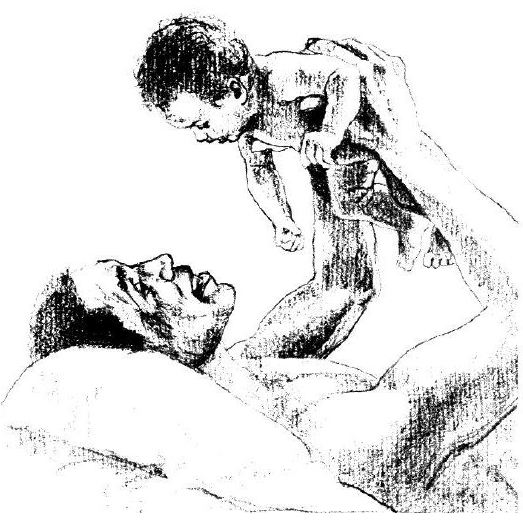
Figure 29. Father plays with baby (U.S. Department of HHS 1989).